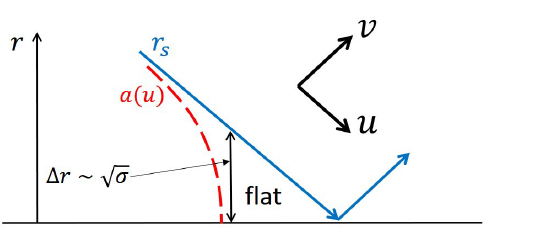
Figure A2. The final stage of the evaporation in a lightlike coordinate ( u , v )